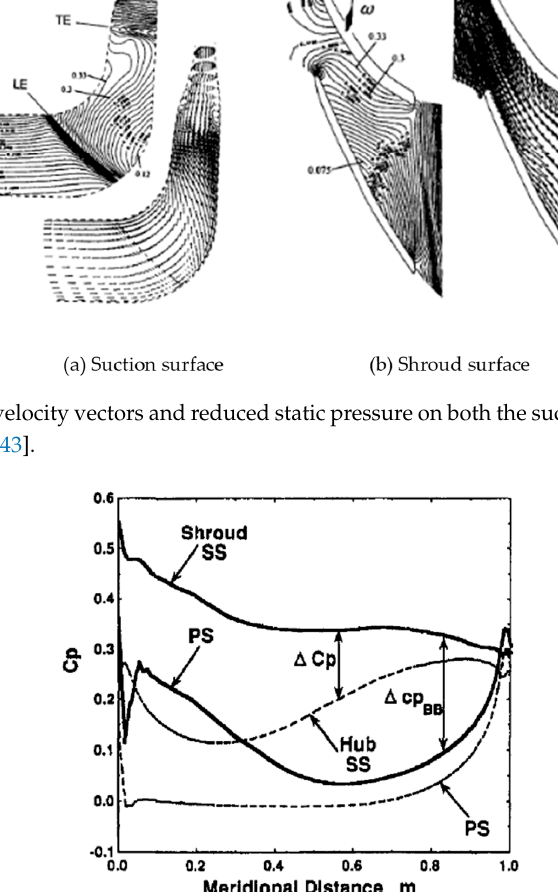
Figure 5. Blade loading specified based on secondary flow control theory and corresponding pressure distribution [43]. Figure 6. Simulated velocity vectors on both the suction surface and shroud surface of the blade [43]. Goto et al. [10] applied above secondary flow control theory to pump design by tailoring both the blade loading distribution and blade stacking condition. The secondary flow in meridional channel is suppressed effectively, as shown in Figure 7. By using the ideal type of stacking condition as suggested by Zangeneh [43–45], the jet-wake flow pattern at the impeller exit is also suppressed, as shown in Figure 8.